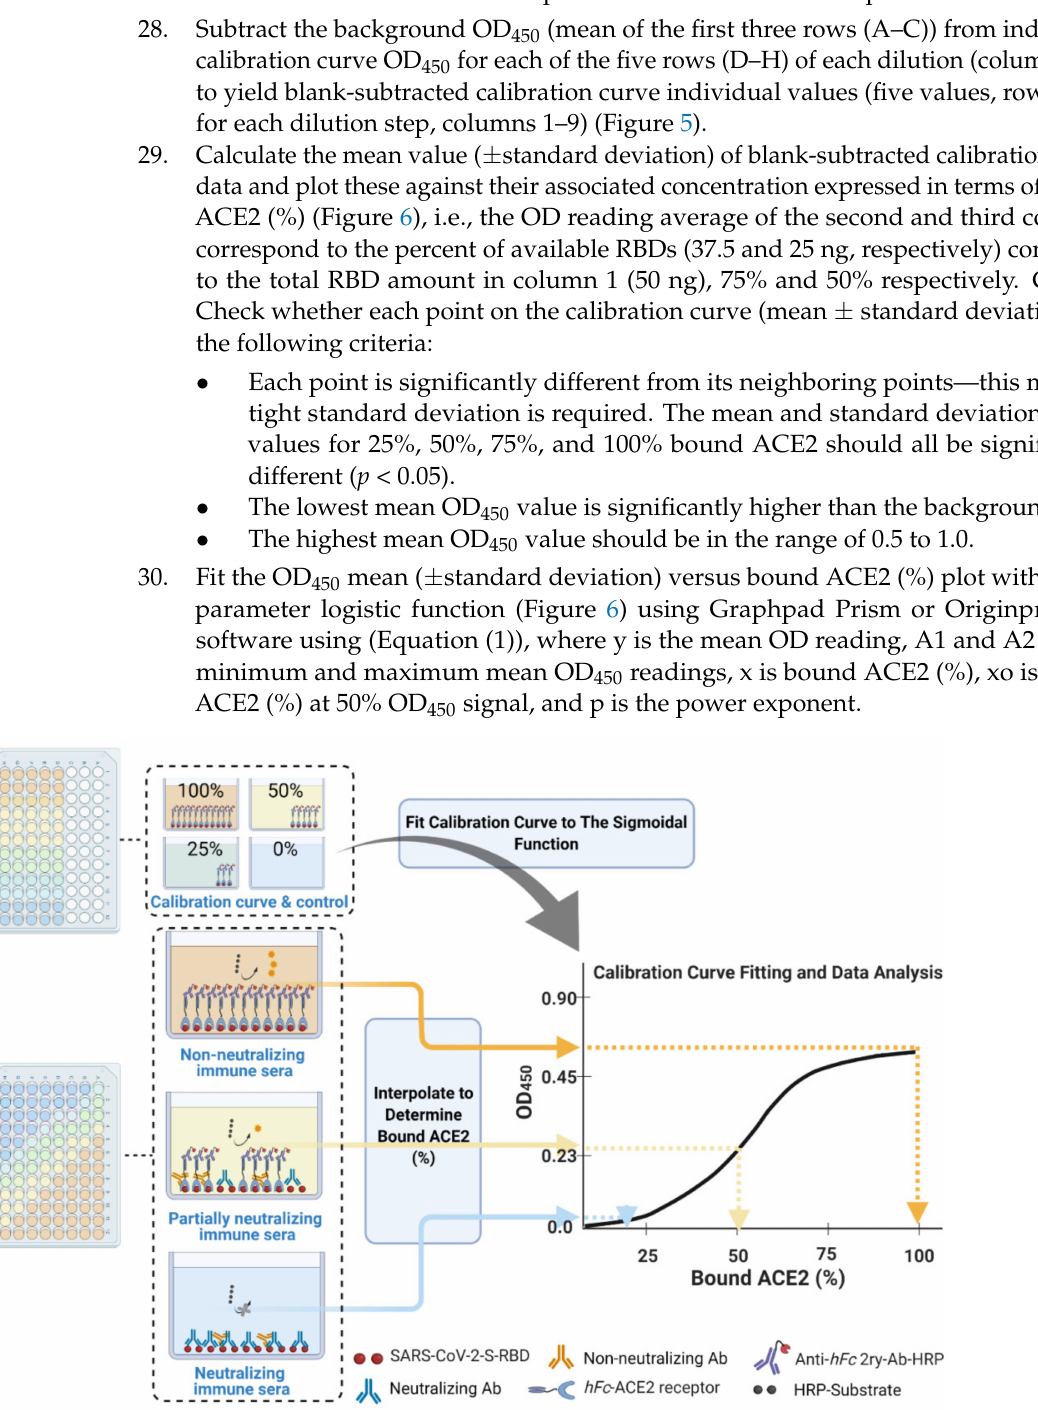
Figure 6. Schematic process diagram showing how to establish a calibration curve plot and interpolate the calibration curve using individual blank ACE2-corrected serum OD readings to obtain bound ACE2 (%) for each serum